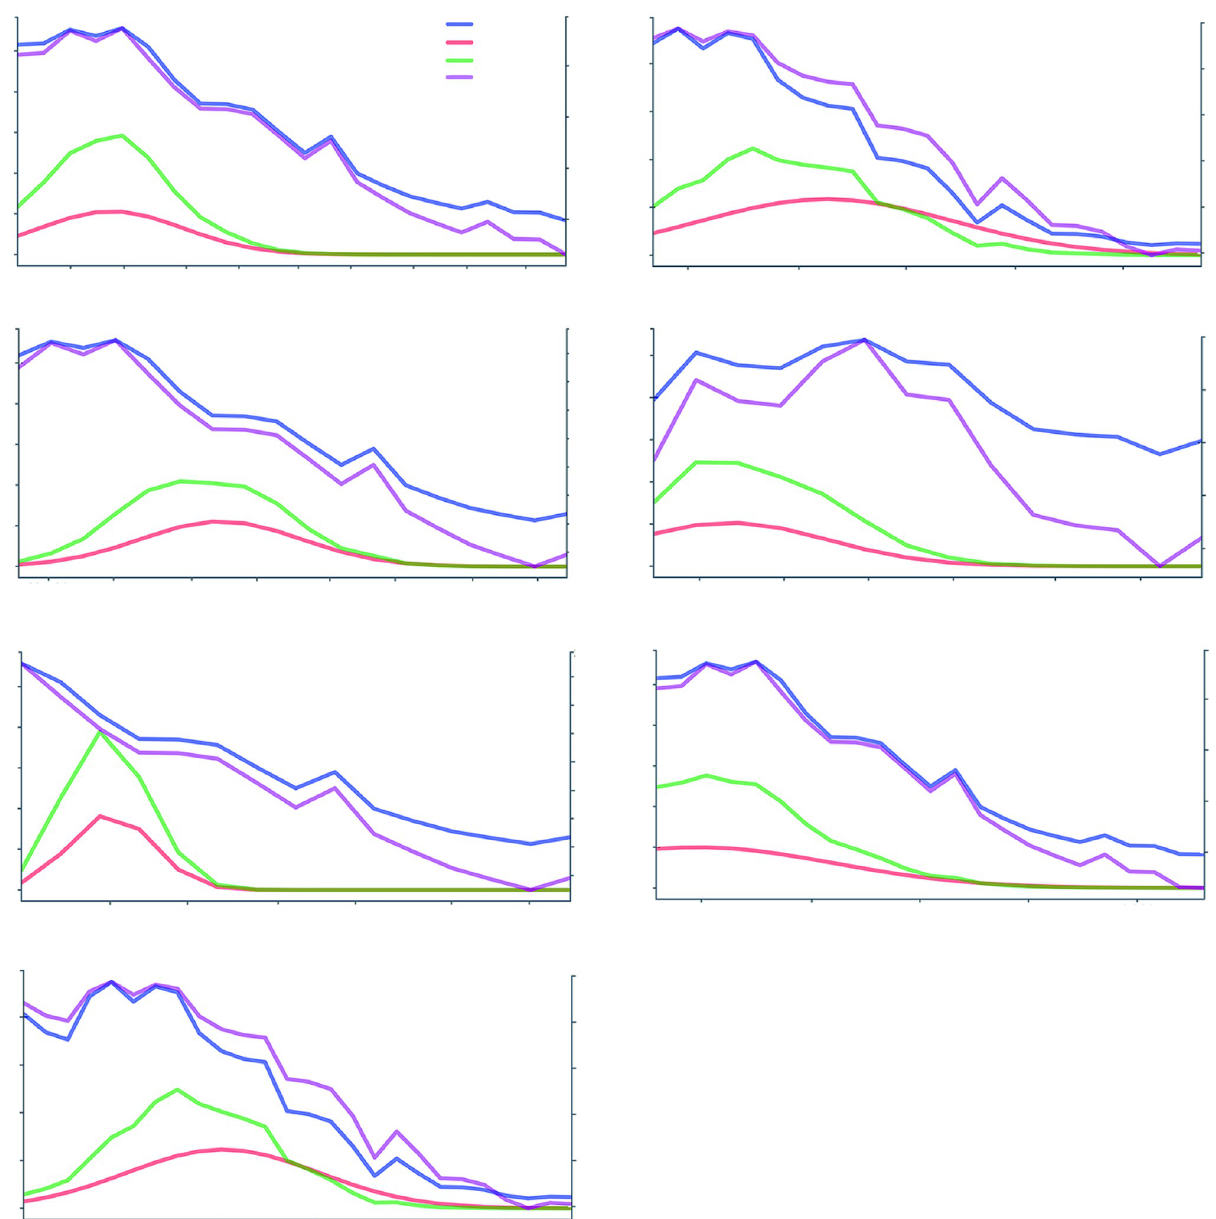
Fig 10. Values of the temperature, bb